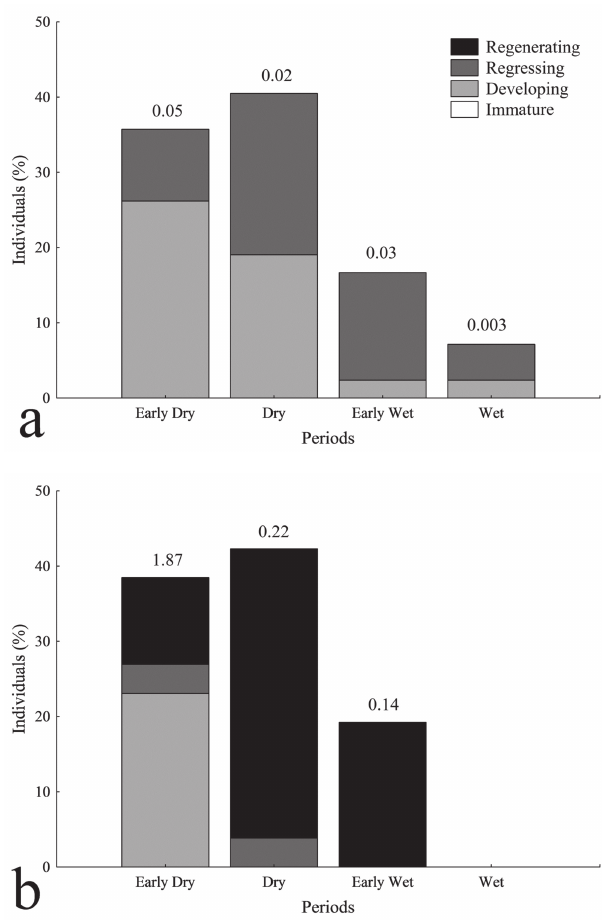
Fig. 4. Percentage of reproductive phases of Mylesinus paucisquamatus among seasonal periods, for males (a) and females (b), upper rio Tocantins. Numbers above bars are the mean gonad-somatic index (GSI, %) for each period. Many individuals in reproduction (64%) were captured in the rio Paranã and its tributaries ( e.g. , Traçadal stream and rio Palmas), while the remainder was recorded in the rio Tocantins and smaller tributaries. The absence of immatures in our samples suggests that first maturation occurs at sizes smaller than 8.2 cm SL for females and 11 cm for